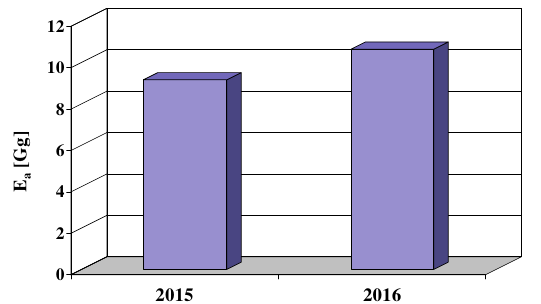
Fig. 13. National annual emission of nitric dioxide from motor vehicles in 2015 and 2016